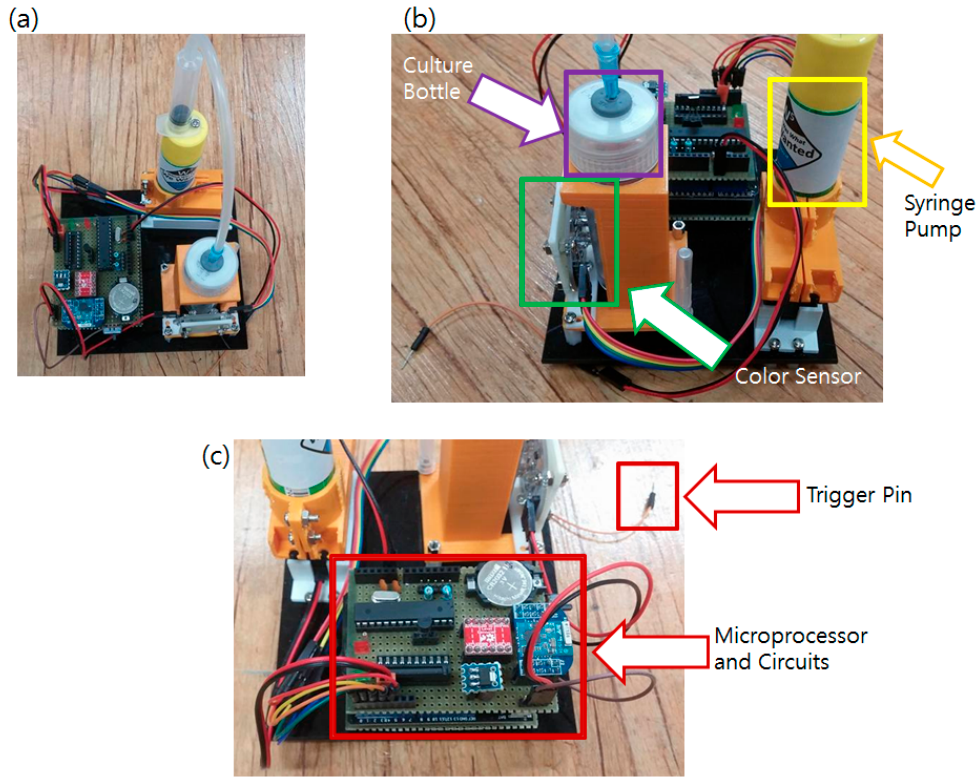
Figure 6. Developed main sensor node. ( a ) Built sensor system; ( b ) Closer view of the color sensor viewing the culture bottle; ( c ) Closer view of the electronic parts.